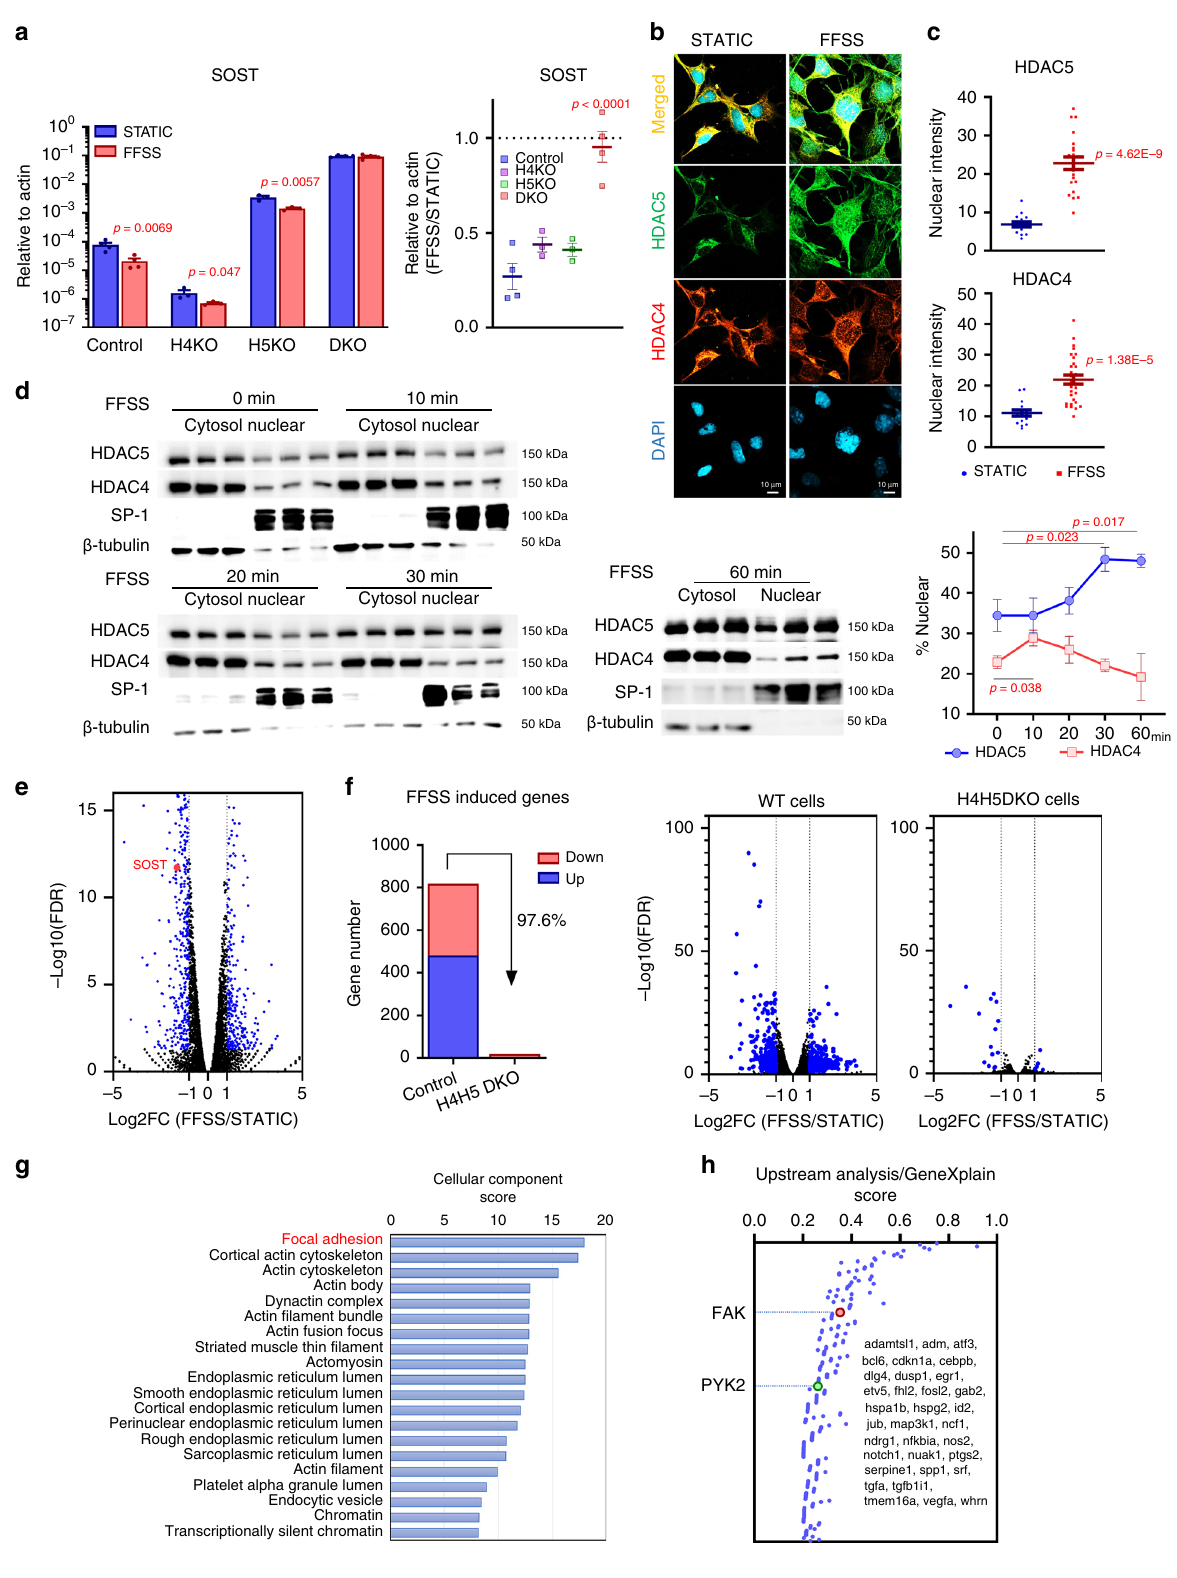
signi fi cantly downregulated transcript in this analysis. Combining inter-related RNA-seq data sets (Fig. 4e), we note that each manipulation (FFSS, FAK deletion, and FAK inhibitor treatment) leads to distinct but overlapping patterns of gene expression changes. First, 200 of the 975 genes regulated by PF562271 were also regulated by FAK gene deletion ( P < 4.987e-13 for